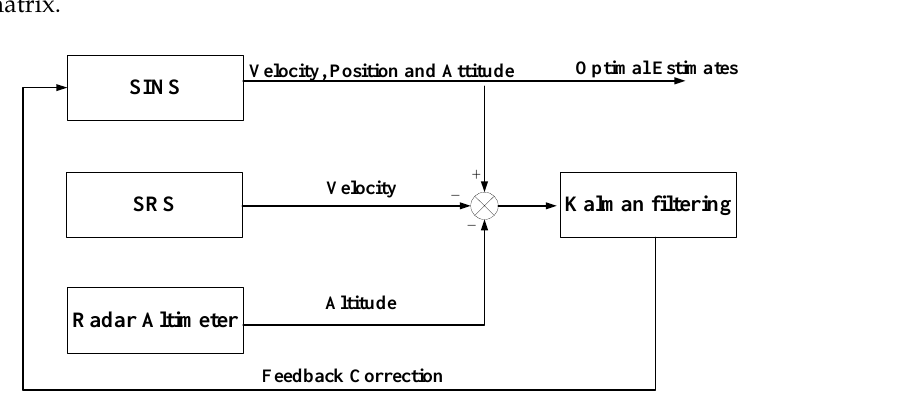
Figure 2. The integrated principle of SINS/SRS integrated subsystem.